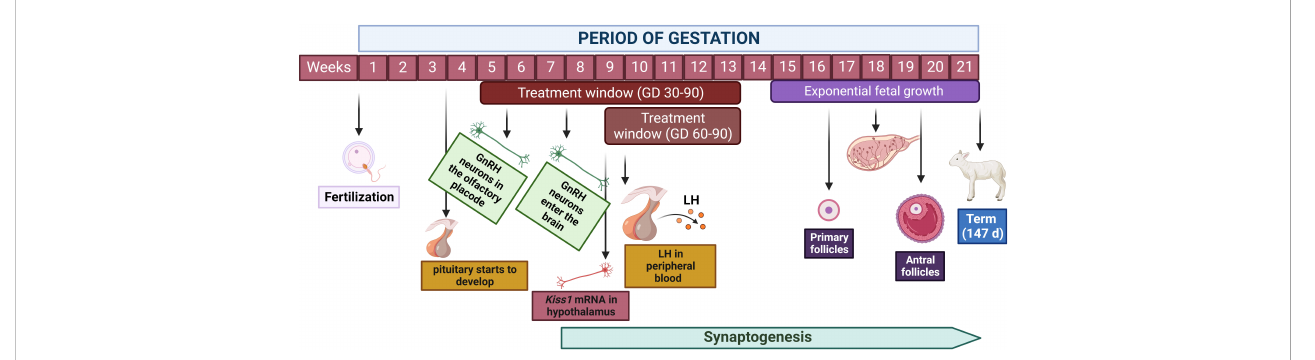
FIGURE 1 Key events during the developmental ontogeny of the reproductive axis in the ovine fetus. Hypothalamic development and migration of GnRH neurons occur primarily between weeks 5 and 10 of gestation, however, synaptogenesis and neuroplasticity persist throughout gestation and early postnatal life. Pituitary development initiates around day 20 of gestation and LH is detected in the peripheral blood at day 56 of gestation. Primary follicles are present starting on week 17 of gestation while antral follicles develop starting on week 20. This timeline of fetal organogenesis in sheep is developed based on the following references (30, 51, 52, 55, 56). Created with